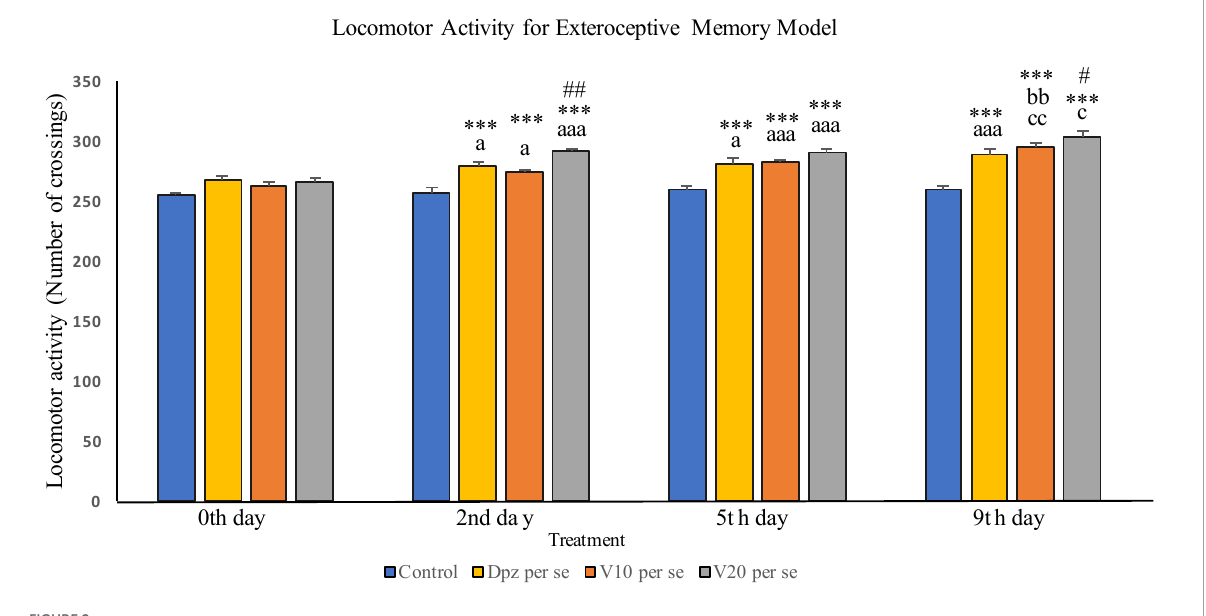
FIGURE2 Effect of vanillin and other treatments on locomotor activity. Data are expressed as mean ± SEM. “***” denotes P < 0.001 with respect to the vehicle control group within the same day. “##” denotes P < 0.01 with respect to the standard treatment group within the same day, and “#” denotes P < 0.05 with respect to the standard treatment group within the same day. “aaa” denotes P < 0.001 with respect to the same group during the 0th day, and “a” denotes P < 0.05 with respect to the same group during 0th day. “bb” denotes P < 0.01 with respect to the same group during the 2nd day. “cc” denotes P < 0.01 with respect to the same group during the 5th day, and “c” denotes P < 0.05 with respect to the same group during the 5th